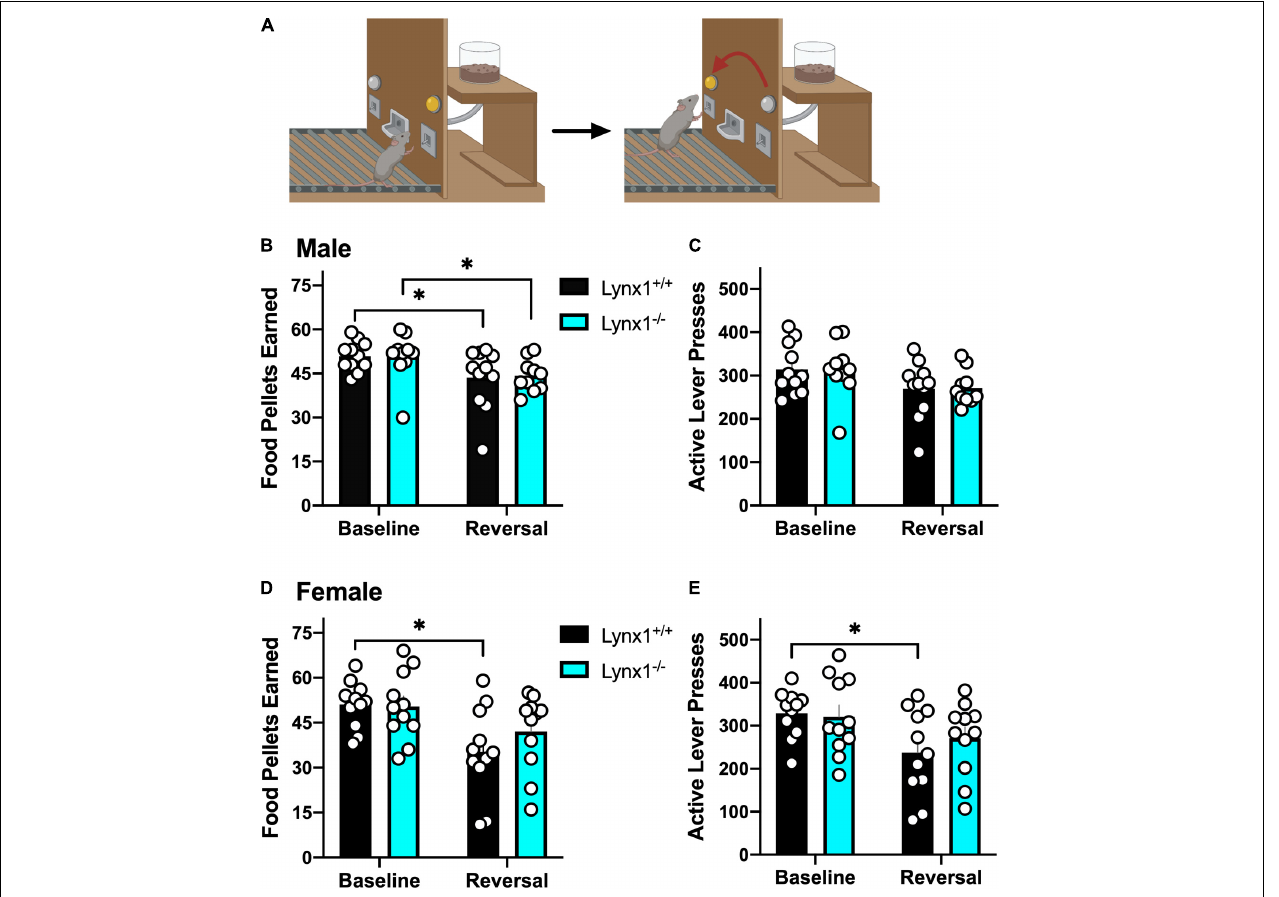
FIGURE 4 | Assessment of the role of lynx1 in cognitive flexibility. (A) Schematic demonstrating the reversal learning paradigm, in which the active lever is reversed after the mice have established a baseline level of responding for food reward. (B,C) Male lynx1 − / − and lynx1 + / + mice ( n = 10–11/group) displayed a significant decrease in the number of food pellets earned (B) , but no difference in the number of active lever presses (C) , comparing the baseline to the reversal session. (D,E) Female lynx1 − / − and lynx1 + / + mice ( n = 11/group) were also assessed in the reversal learning task. The female lynx1 − / − mice exhibited a similar level of lever pressing behavior across sessions, with no differences in the number of food pellets earned (D) or active lever presses (E) in the reversal session compared to their baseline level of responding. In contrast, the lynx1 + / + mice displayed a significant decrease in both of these measures for the reversal session. ∗ p < 0.05. Individual data points shown as white circles, and the bars represent mean ± SEM. Image created with